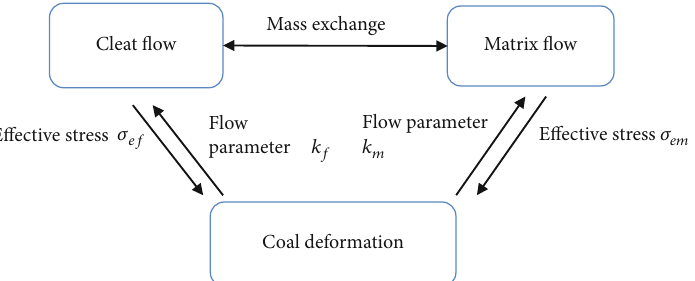
Figure 10: Schematic de fi ning cross-couplings among four physical processes: matrix deformation, fracture deformation, gas fl ow in the matrix, and gas fl ow in the fracture.